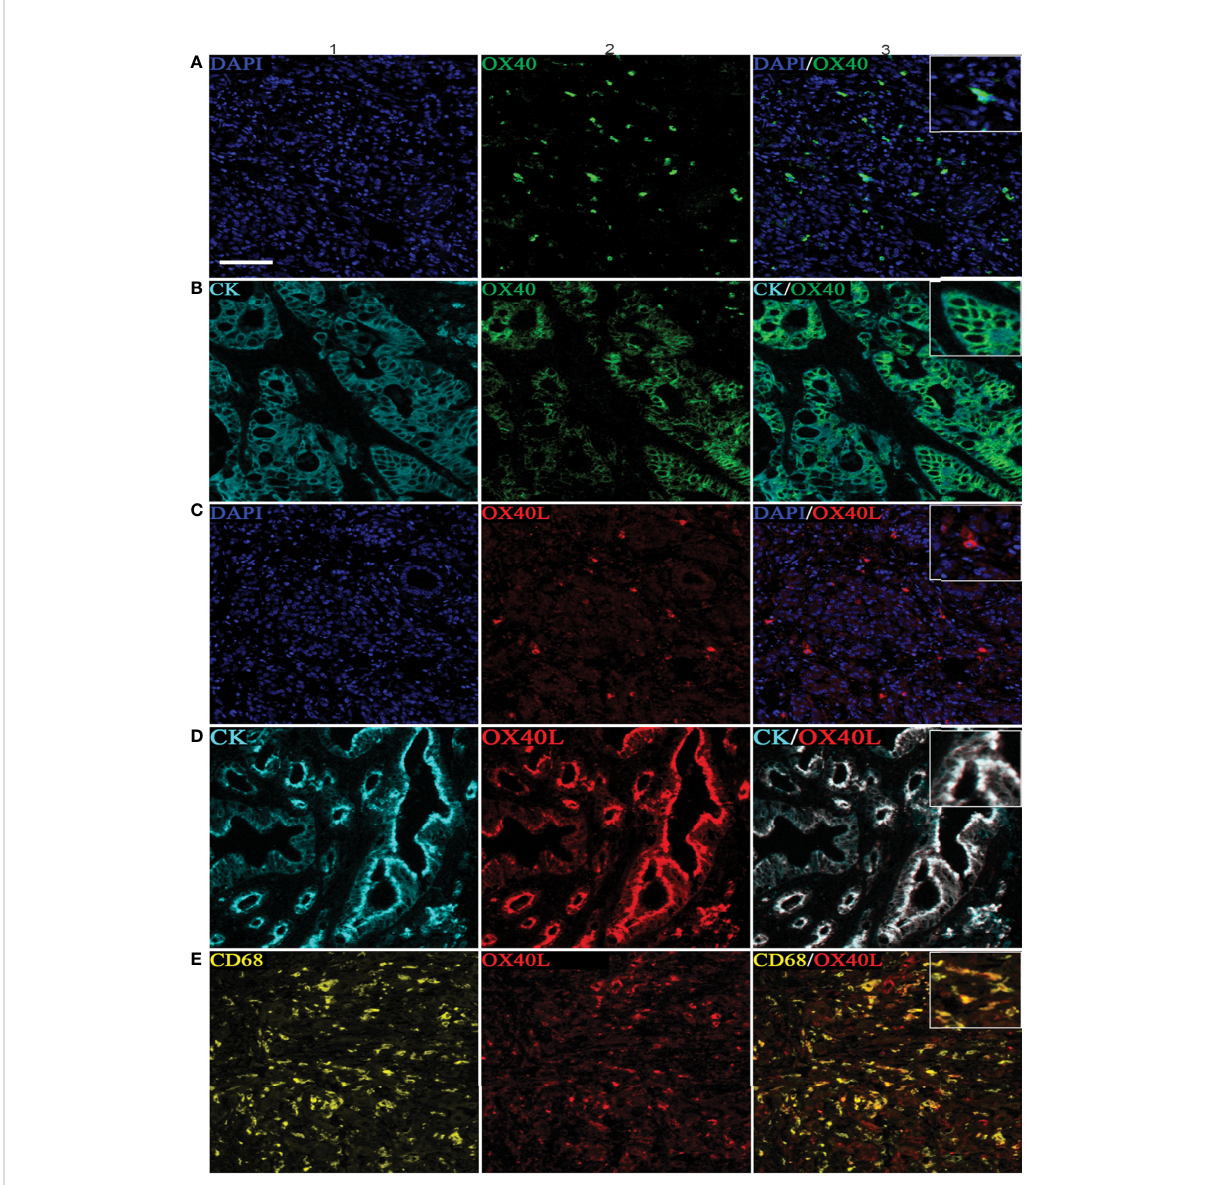
FIGURE 2 Positive OX40 expression on tumor cells (TCs) and immune cells (ICs) and positive expression of OX40L on TCs, ICs, and macrophages. Representative images of A1 – A3, which are OX40 positive on ICs: individual component OX40 positivity on ICs obtained from multiplexed slides after spectral unmixing (OX40+, A1 ), cell nucleus (4 ′ ,6-diamidino-2-phenylindole [DAPI], A2 ), and two-color multispectral (OX40+ ICs, A3 ). Representative images of (B1 – B3) , which are OX40 positive on TCs: OX40 positivity on TCs (OX40+, B1 ), tumor cell positivity (CK+, B2 ), and two-color multispectral imaging (OX40+/CK+, B3 ). Representative images of corresponding (C1 – C3) , which are OX40L on ICs (C1 – C3) . Representative images of corresponding (D1 – D3) , which are OX40L on TCs (D1 – D3) . Representative images of corresponding (E1 – E3) , which are OX40L on macrophages (E1 – E3) . DAPI (blue), CK (cyan), OX40 (green), OX40L (red), CD68 (yellow), and CD8 (purple). (200×magni fi